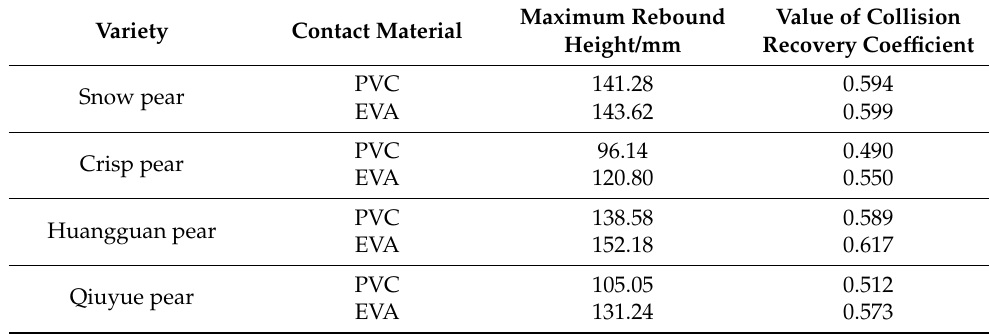
Table 4. Measured values of collision recovery coefficients between typical pears and